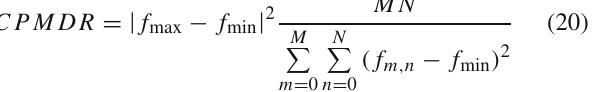
Fig.4 Samplingandadjustmentprocess.(1)Inthenewframeofimage, sample the image by sliding window according to d scales of different scales in S, and calculate the sample response of each scale, so as to determine the candidate regions of different scales. (2) Adjust these